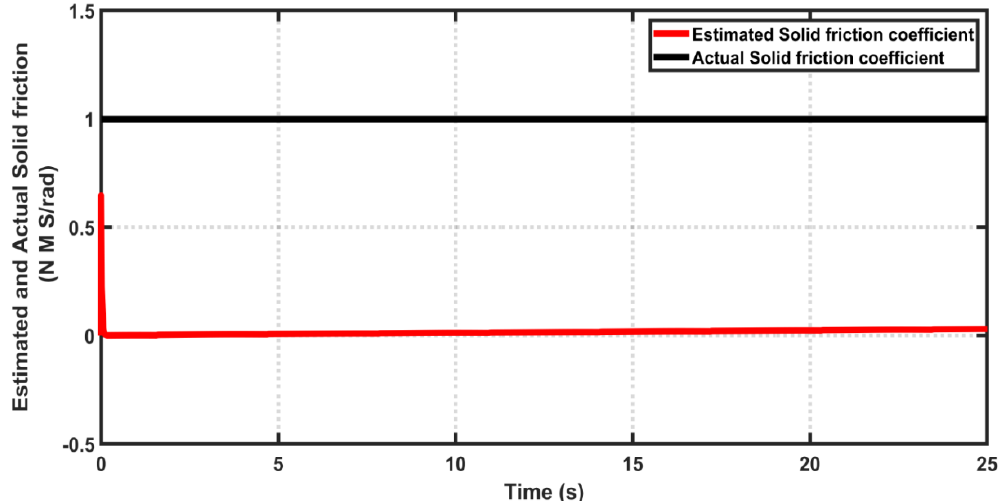
Figure 12. Behaviors of actual and estimated solid friction coefficients f s .